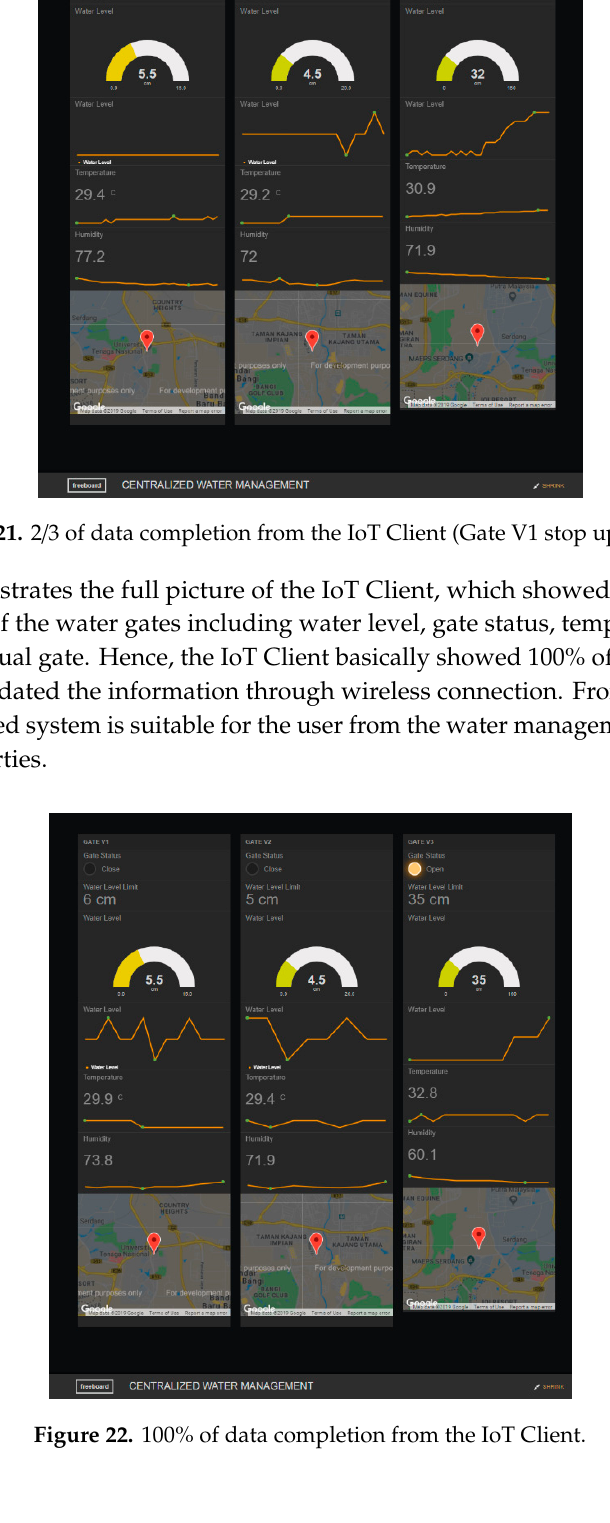
Figure 22. 100% of data completion from the IoT Client.